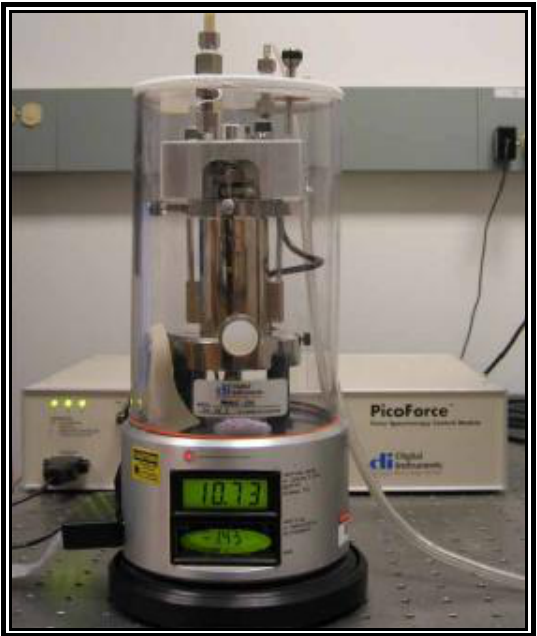
Figure 1: Atomic Force Microscope